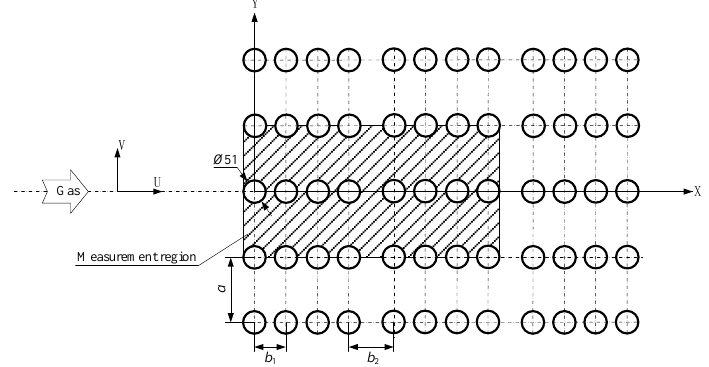
Figure 4. Schematic diagram of the economizer tube bank.